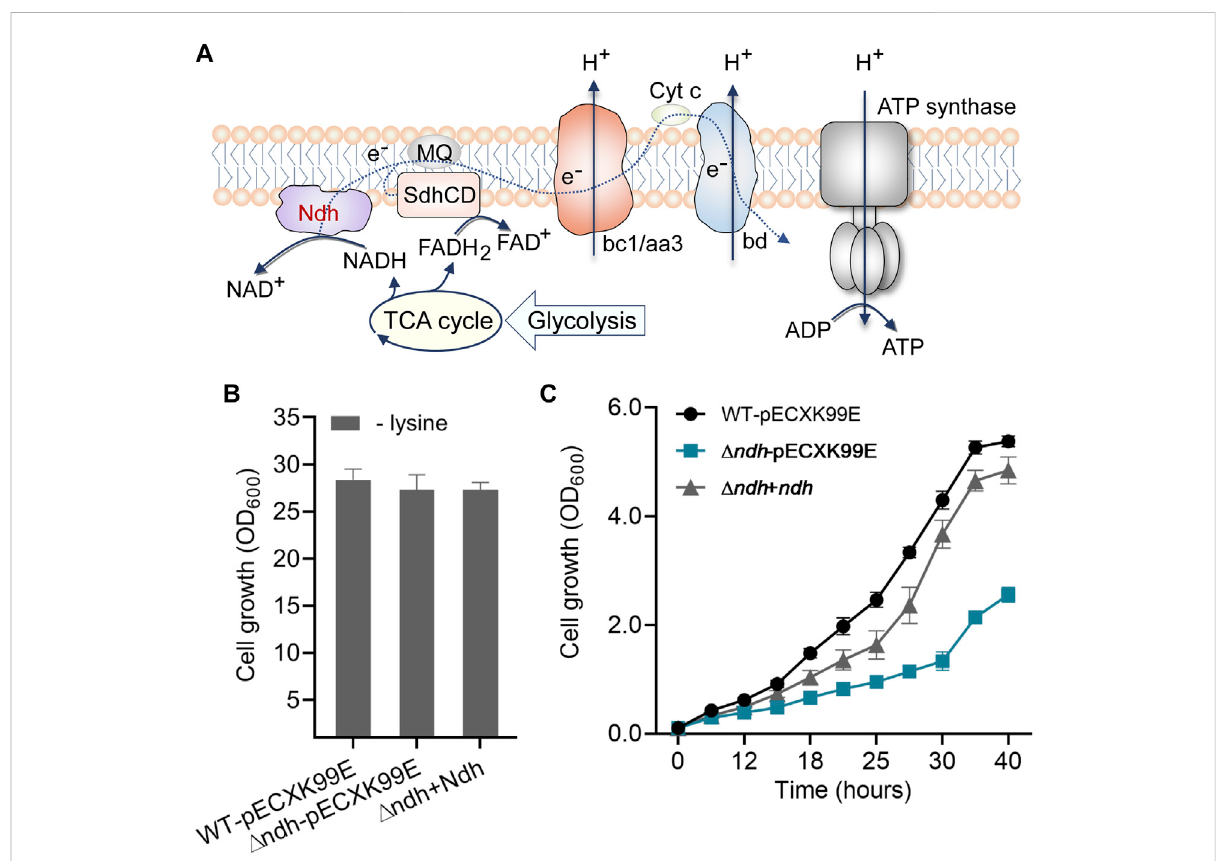
FIGURE 6 Role of the NADH dehydrogenase Ndh in protecting cells against high-lysine-induced osmotic stress. (A) Schematic diagram of Ndh in the oxidative phosphorylation pathway. (B,C) Growth assays of the wild-type, Δ ndh , and complemented strains without or with a high-lysine challenge.